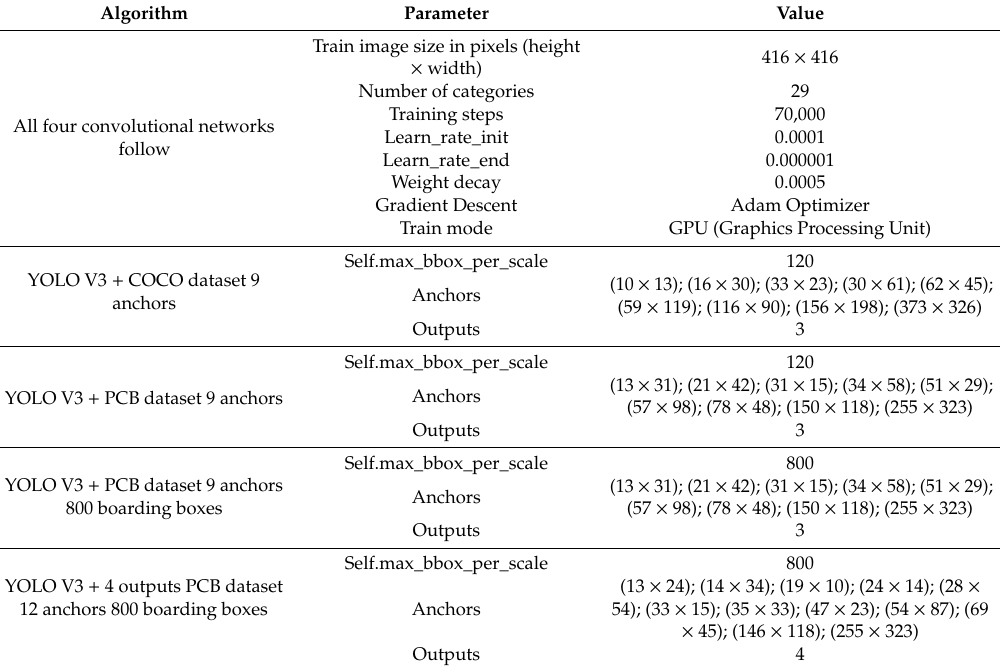
Table 3. Experimental execution